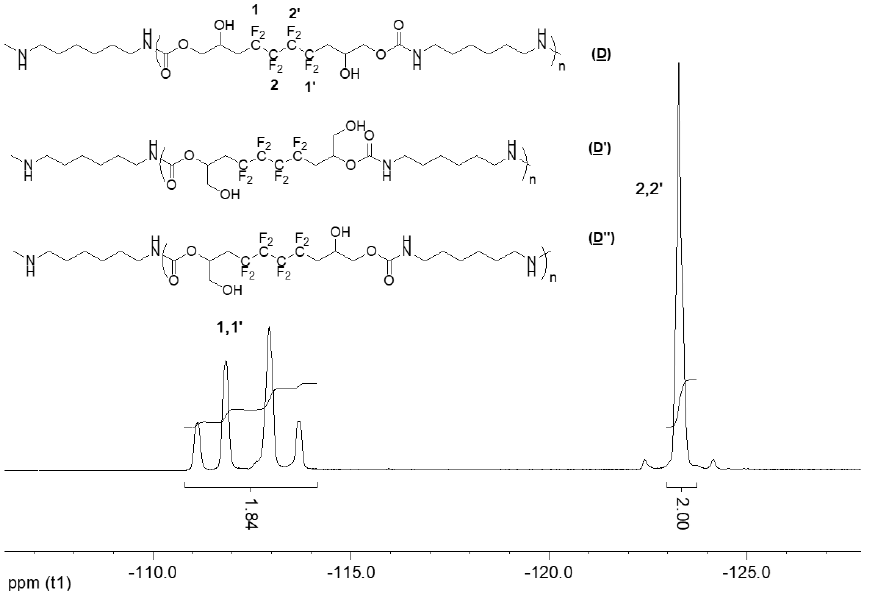
Figure 10. 19 F NMR spectrum of the synthesized P3 ( D ), ( D′ ), and ( D″ ) (DMSO-d6, 20 °C, 235.2 MHz) .